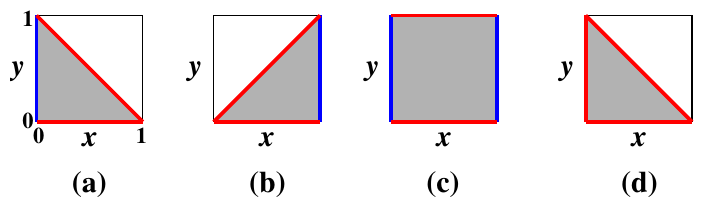
Figure 13 . The integration regions (shaded) for the various terms in (3.11) corresponding to (a) Class I virtual diagrams, (b) their x 1 x cousins, (c) Class II virtual diagrams, and (d) ! (cid:0) g ggg diagrams. The colored lines correspond to limits of the integration regions, which generate ! IR divergences. See the caption of (cid:12)gure 15 for the distinction between the red vs. blue lines